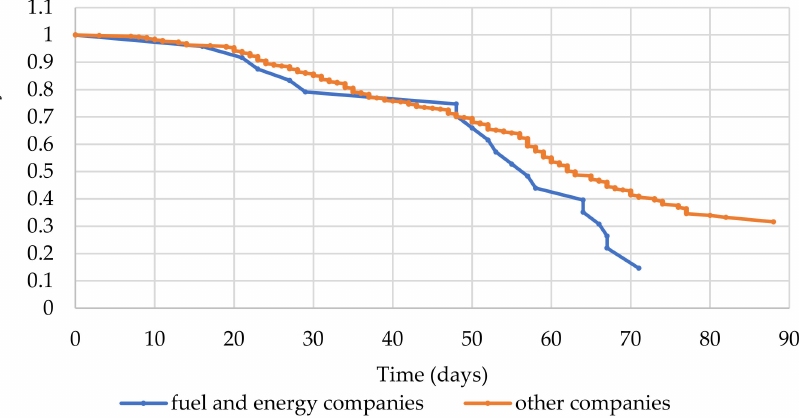
Figure 4. Kaplan-Meier estimators for energy and fuel companies and other companies. Source: own elaboration on the basis of data from https://www.gpw.pl [73] (accessed on 19 June